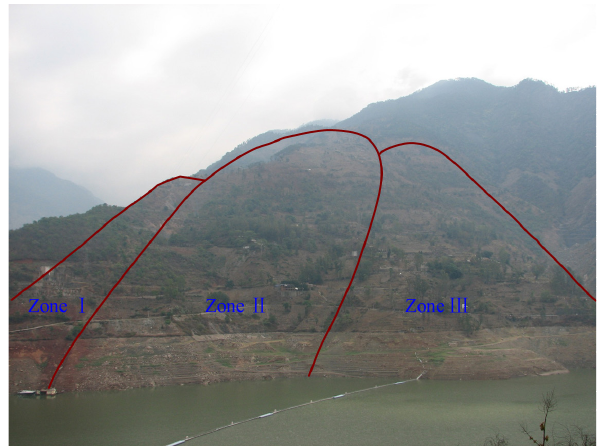
Fig. 2. The whole view of the landslide.